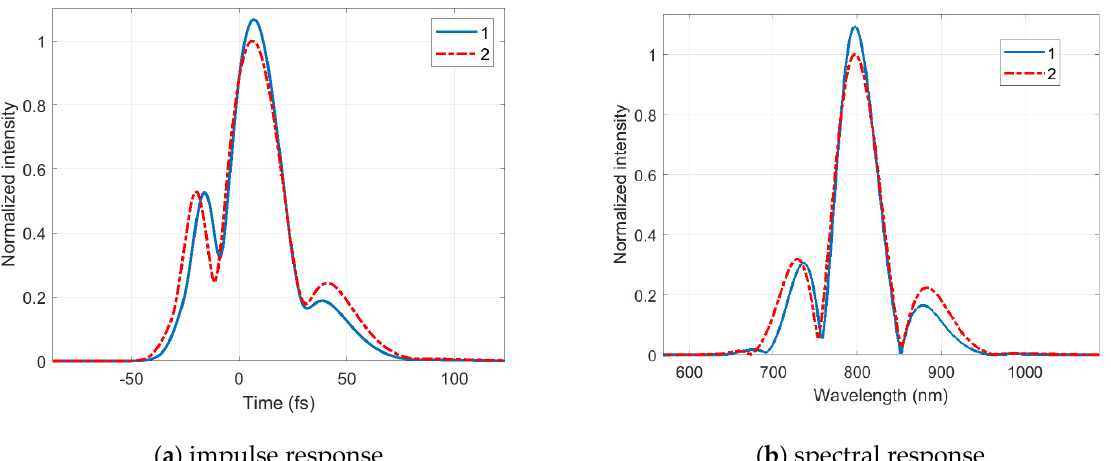
Figure 2. The simulation results: 1—proposed algorithm; 2—known algorithm. ( a ) impulse response; ( b ) spectral